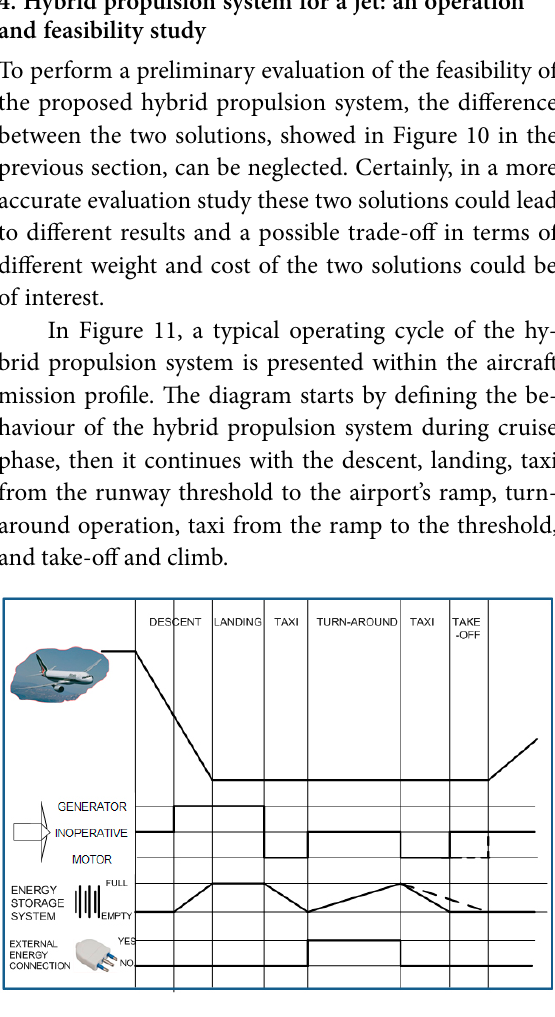
Fig. 11. Hybrid propulsion system operation cycle from the aircraft’s descent to take-off